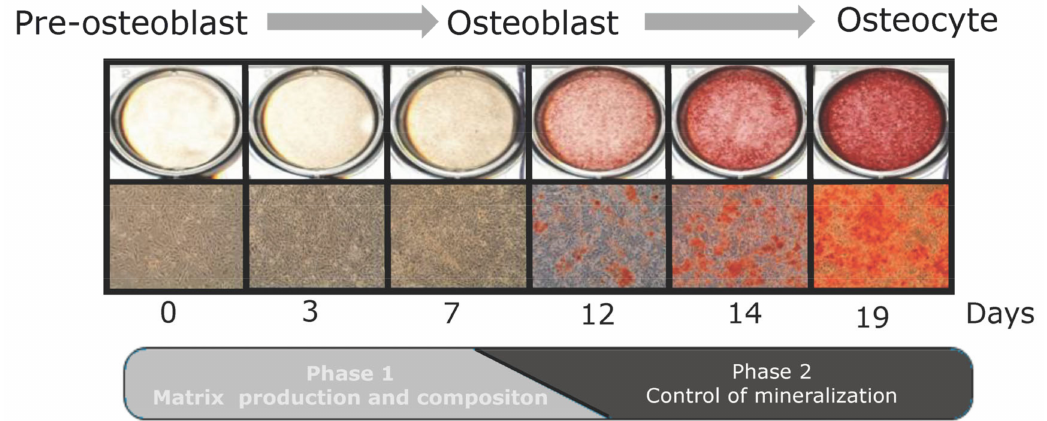
Figure 1. Alizarin red staining of osteoblast culture exemplifying the pre-mineralization and mineral- ization phases. Red staining shows mineralization. Details on cell culture and Alizarin red staining procedures can be found in Woeckel et al. [99]. Adapted with permission from Eijken, M.,